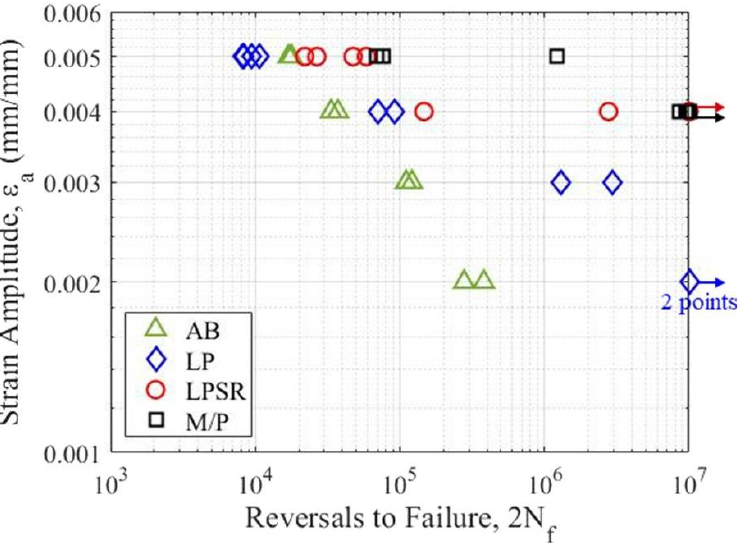
Figure 20. Fatigue data of LP-ed Ti6Al4V samples [83]; with permission from